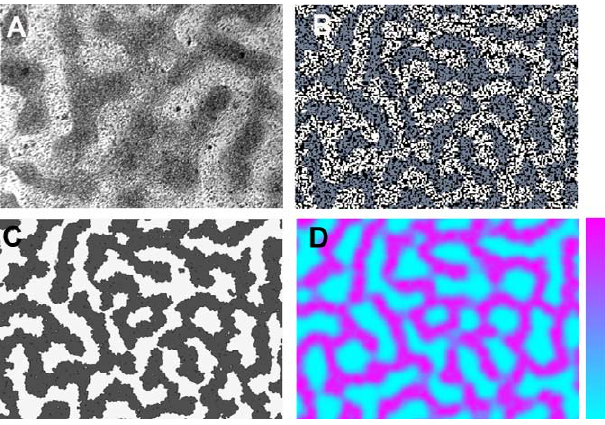
Figure 7. In Vitro and Simulation Images for Stripe-Like Precartilage Condensations (A) Stripe-like precartilage condensations. (B) Spatial grid containing more than 6,000 cells produced by simulation showing stripes of fibronectin-producing differentiated cells (white), nondifferentiated cells (blue-gray), and empty space between cells (black). (C) Spatial grid of same simulation as (B) showing fibronectin-rich stripes (black) produced by the differentiated cells. (D) Spatial grid of same simulation as (B) showing activator concen- trations at time slightly after the initial onset of cell differentiation. The color bar indicates the range, with magenta for high concentration and light blue for low